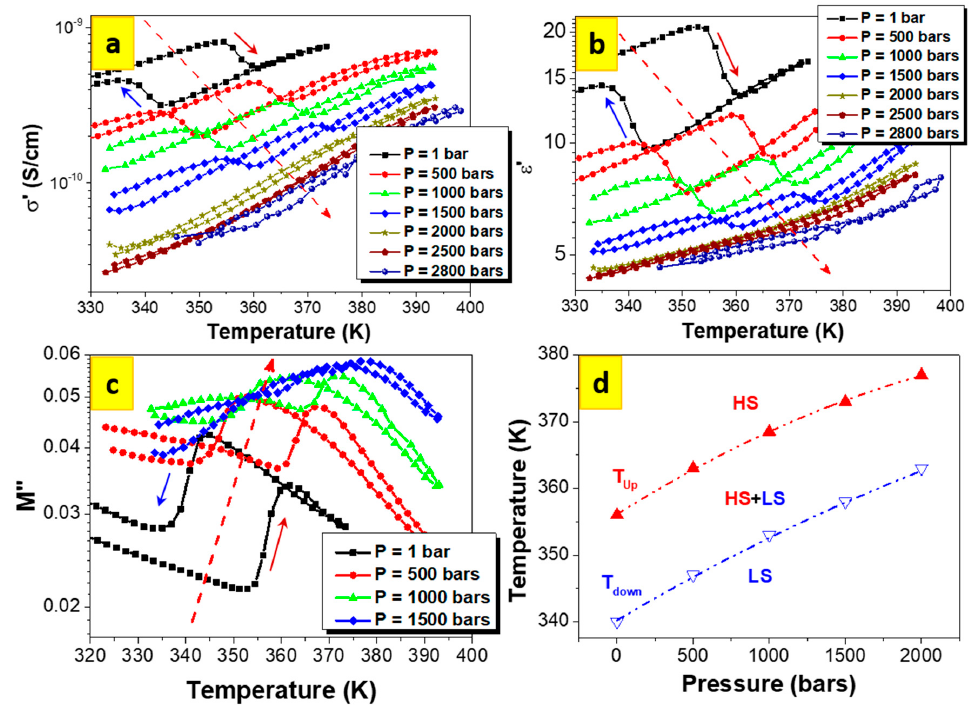
Figure 2. Temperature dependences of ( a ) the real part of the electrical conductivity; ( b ) the real part of the dielectric permittivity; and ( c ) the imaginary part of the electric modulus, recorded at 100 Hz applied electric field frequency for various applied pressures for sample S1 . ( d ) P , T -phase diagram extracted from the electrical measurements. (Dashed lines are guides to the